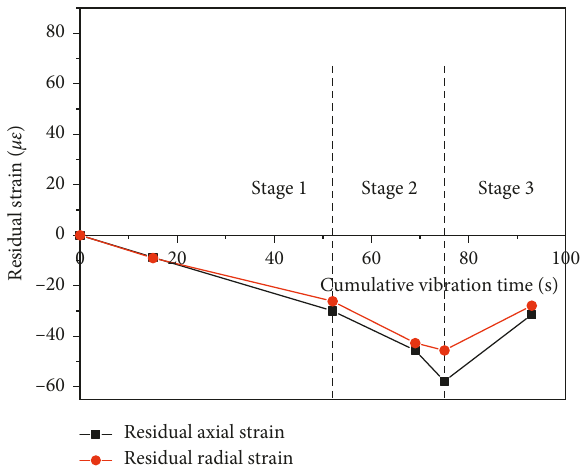
Figure 9: Development of residual strain and elastic strain during the vibration